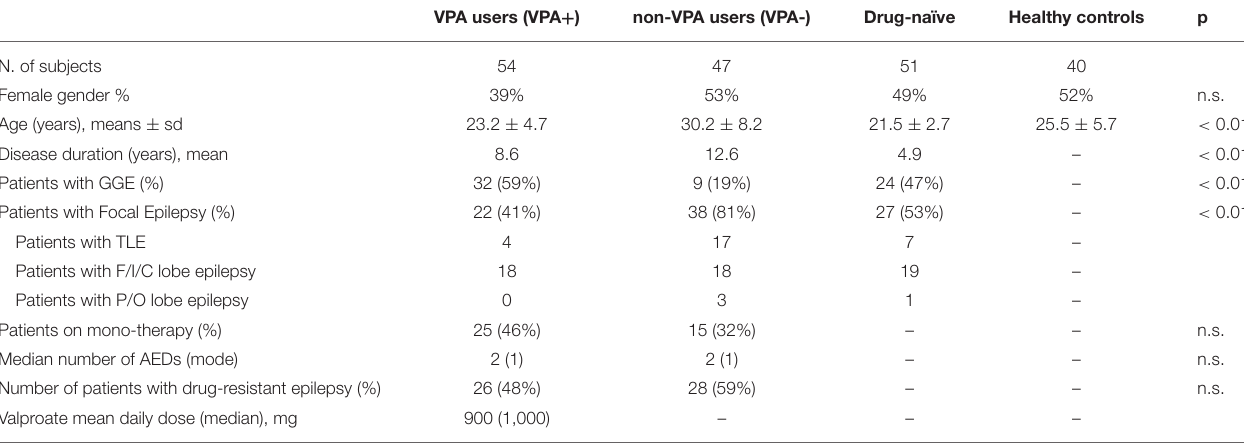
TABLE 1 | Demographic and clinical variables of the different groups according to valproate (VPA) treatment.